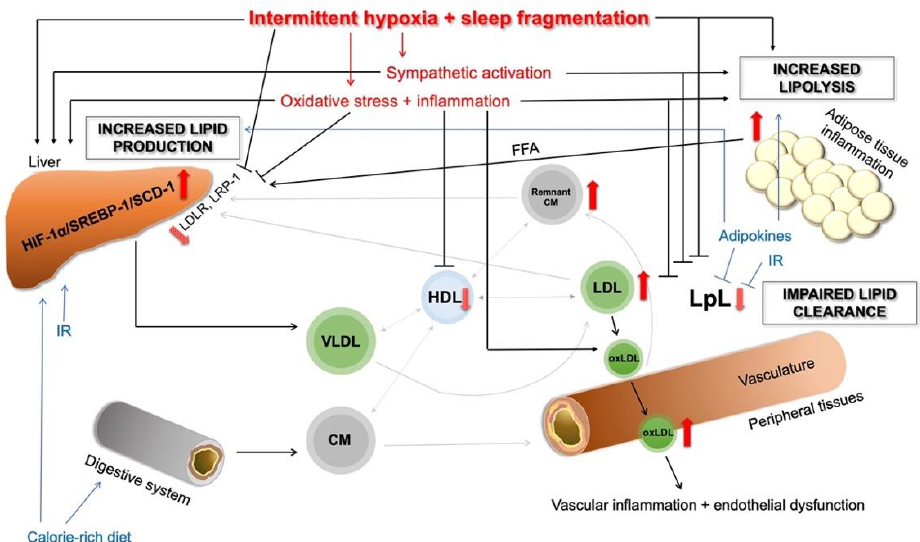
Figure 2. Overview of the main pathophysiological pathways in OSA-related dyslipidaemia. The red arrows show the altered pathways and dysregulations. CM — chylomicron; FFA — free fatty acid; HDL — high-density lipoprotein; HIF- 1α — hypoxia-inducible factor 1 alpha; IR — insulin resistance; LDL — low-density lipoprotein; LDLR — low-density lipoprotein receptor; LpL — lipoprotein lipase; LRP-1 — LDL receptor-related protein 1; oxLDL — oxidised-LDL; SCD-1 — stearoyl-coenzyme A desaturase 1; SREBP-1 — sterol regulatory element-binding protein 1; TG — triglyceride; VLDL — very-low-density lipoprotein. For description and references, please see the text.